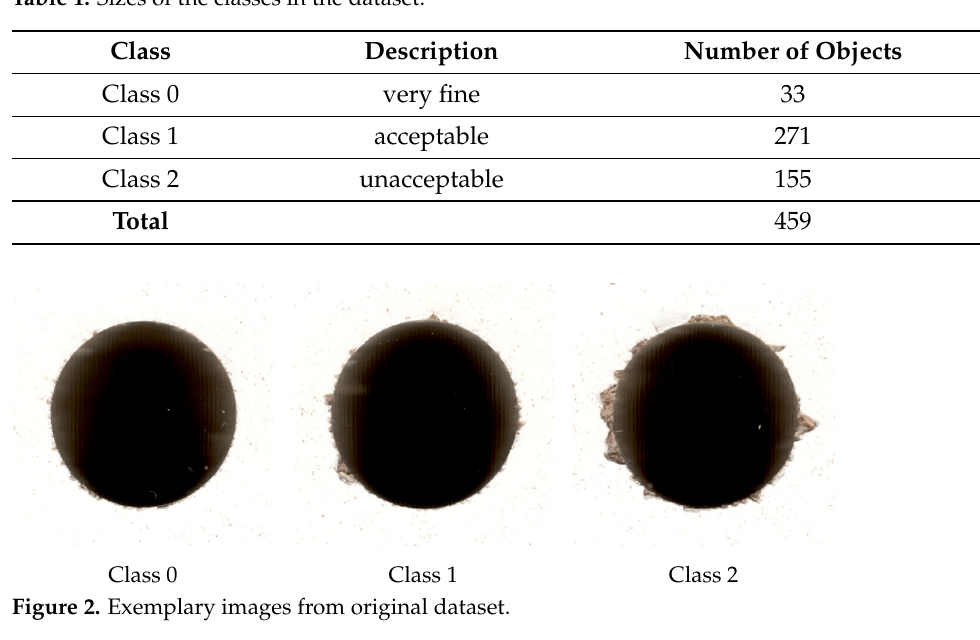
Table 1. Sizes of the classes in the dataset.